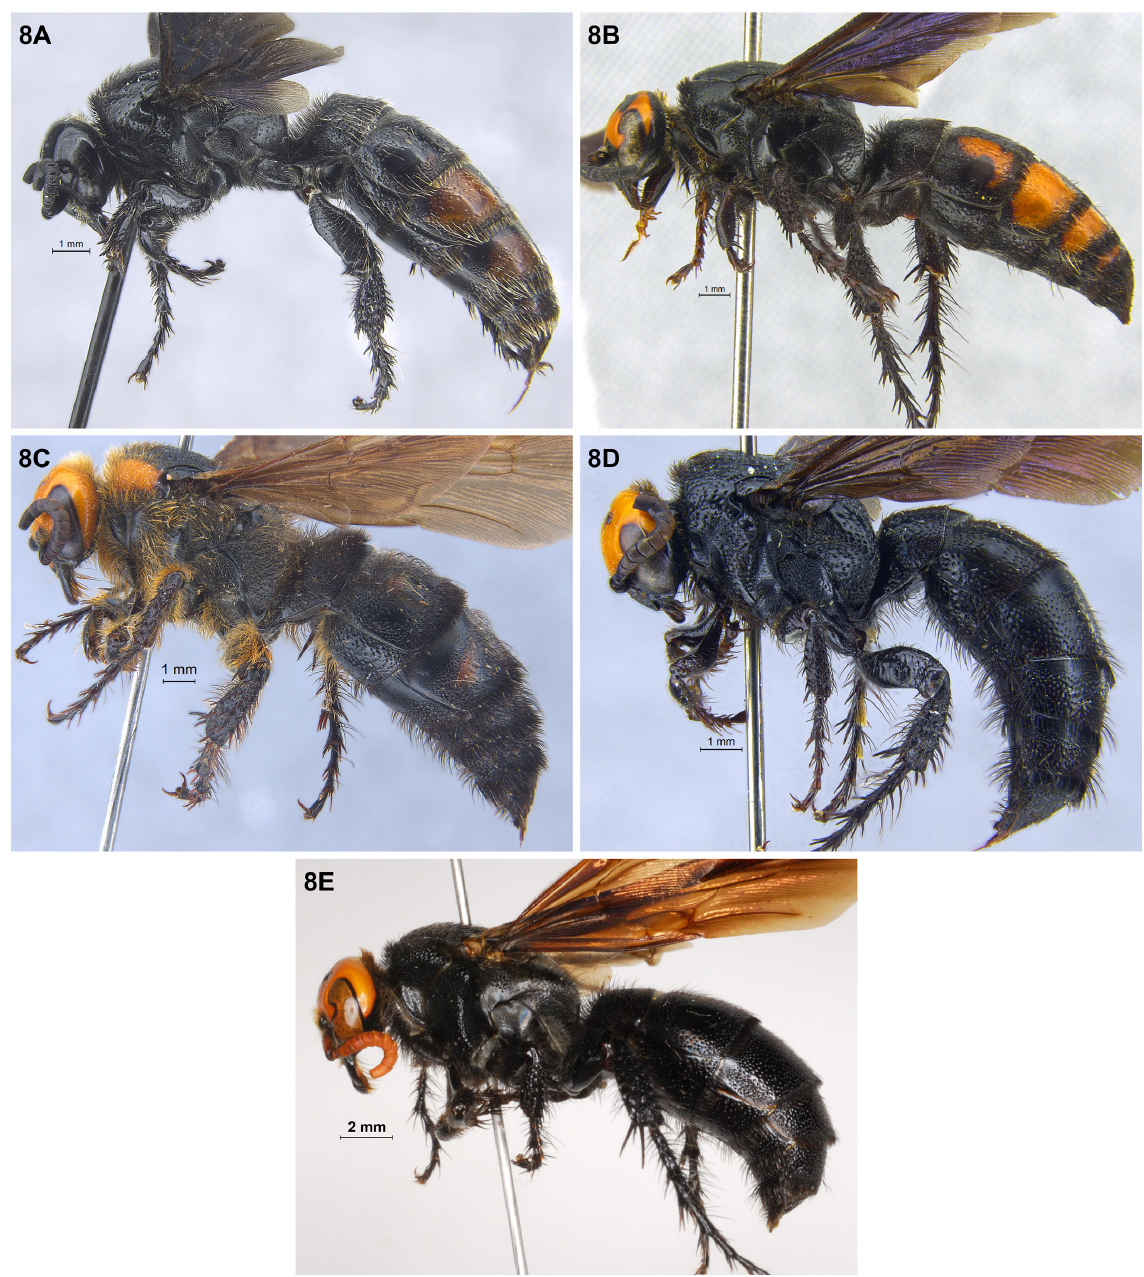
Fig. 8. Females, lateral habitus. A . Scolia binotata Fabricius, 1804. B . Sc. binotata orange